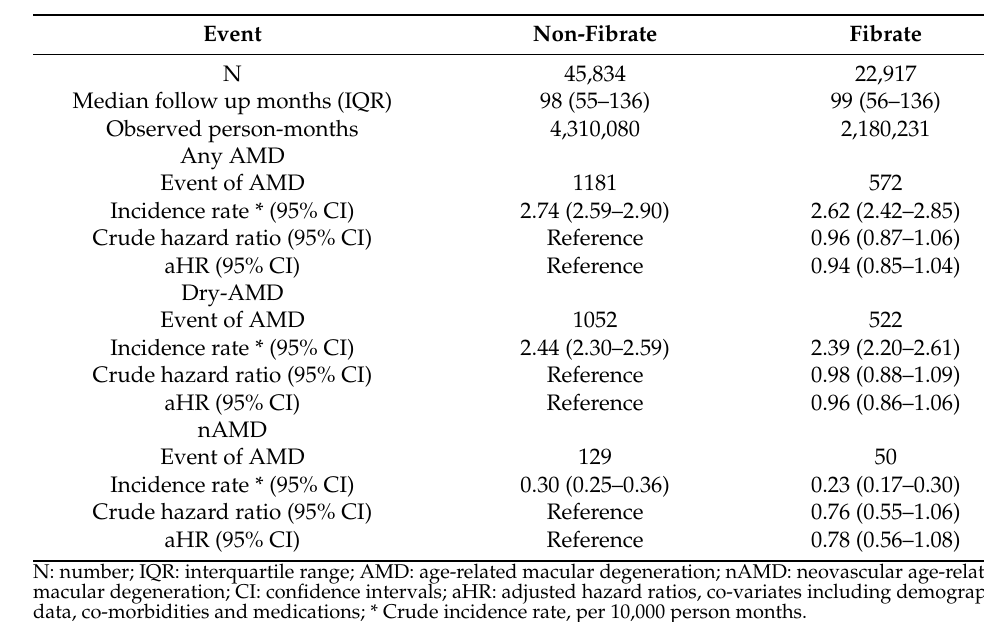
Table 5. Sensitivity analysis for the incidence of age-related macular degeneration.